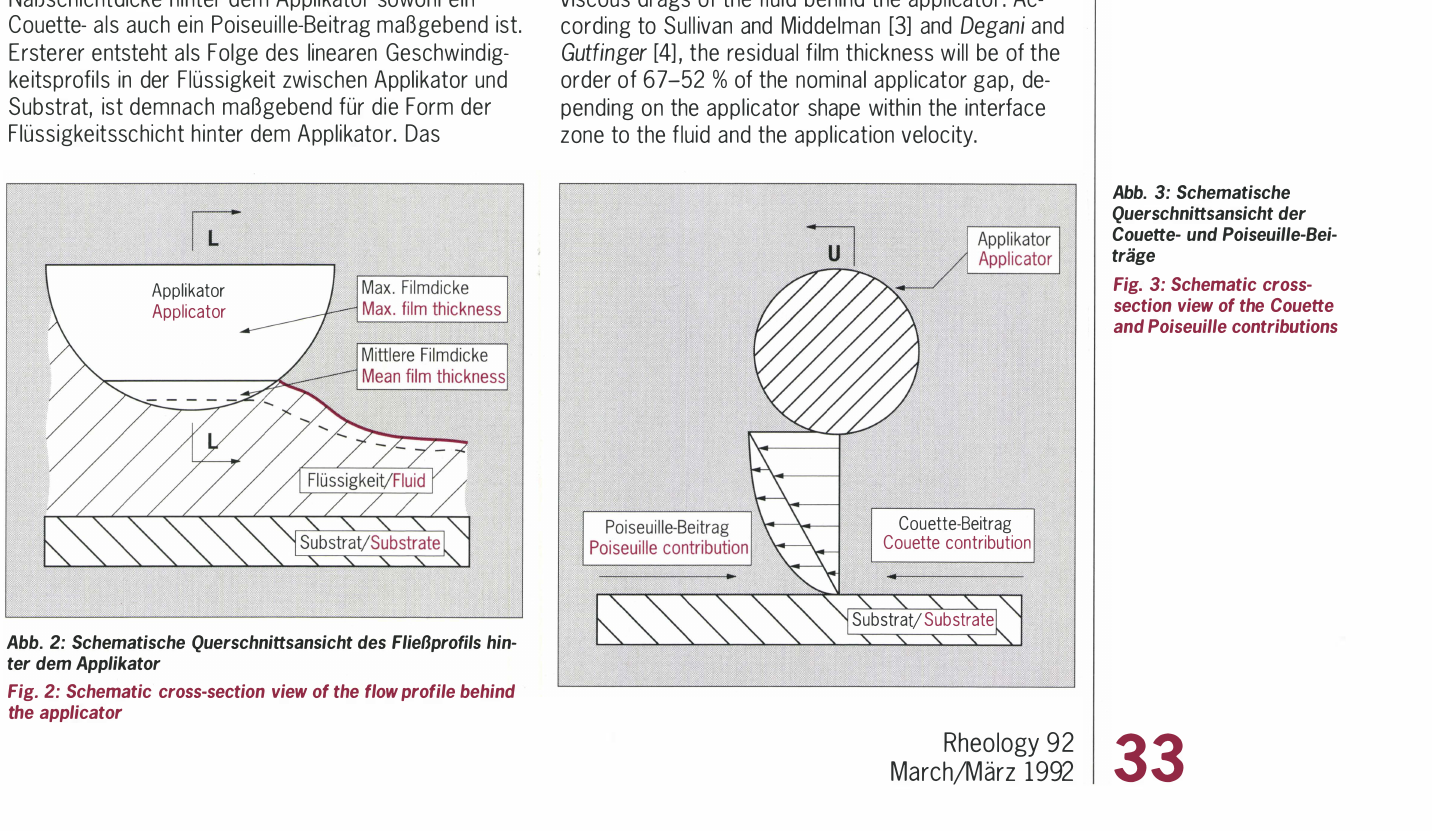
Fig. 3: Schematic cross­ section view of the Couette and Poiseuille